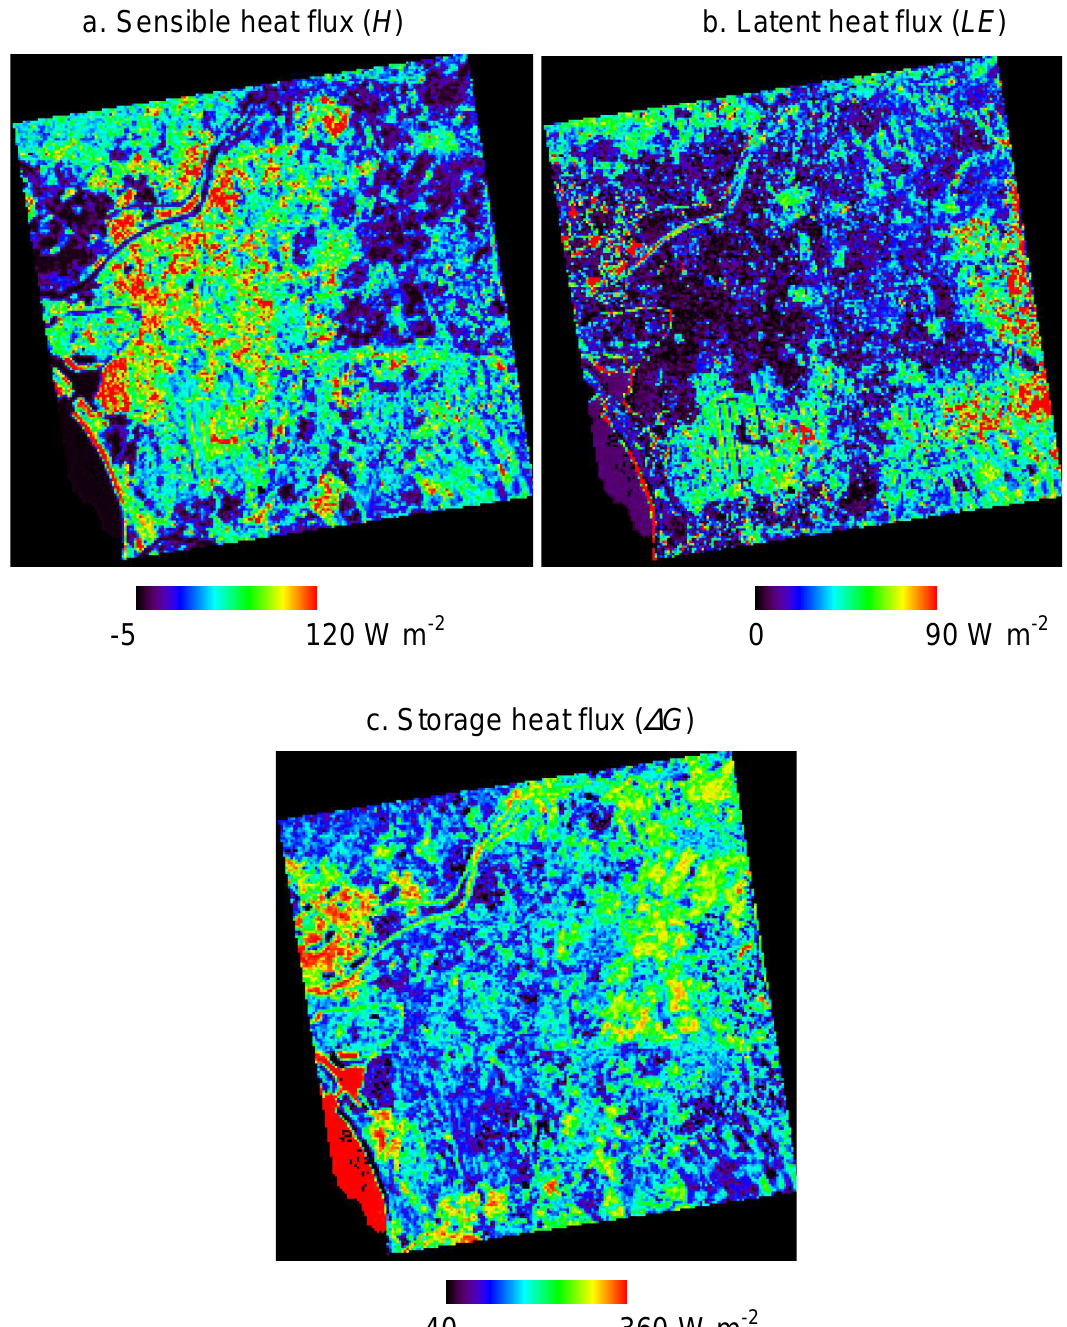
Figure 5. Distributions of (a) sensible heat flux H , (b) latent heat flux LE , and (c) storage heat flux D G estimated by using a surface classification map from Formosat-2